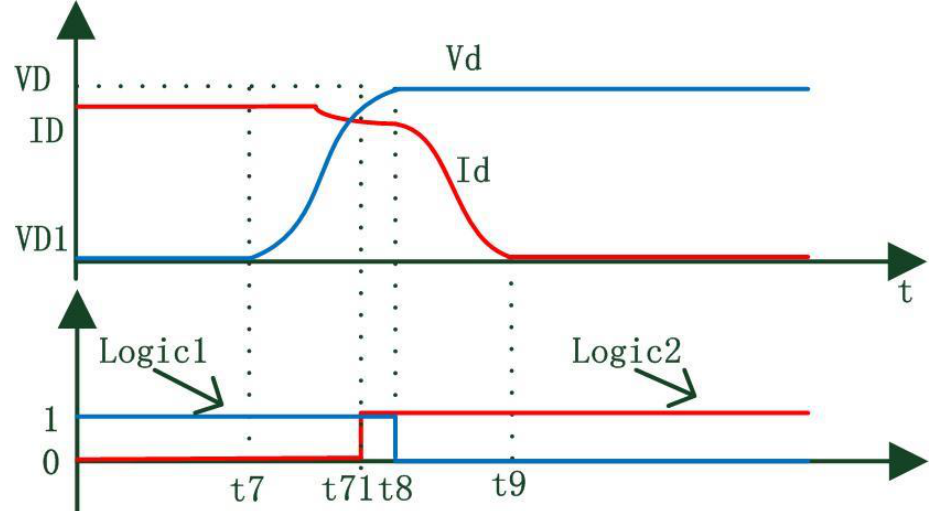
Figure 8. Turn-off voltage and current waveform of SiC MOSFET in the proposed circuit. Figure 8. Turn-o ff voltage and current waveform of SiC MOSFET in the proposed